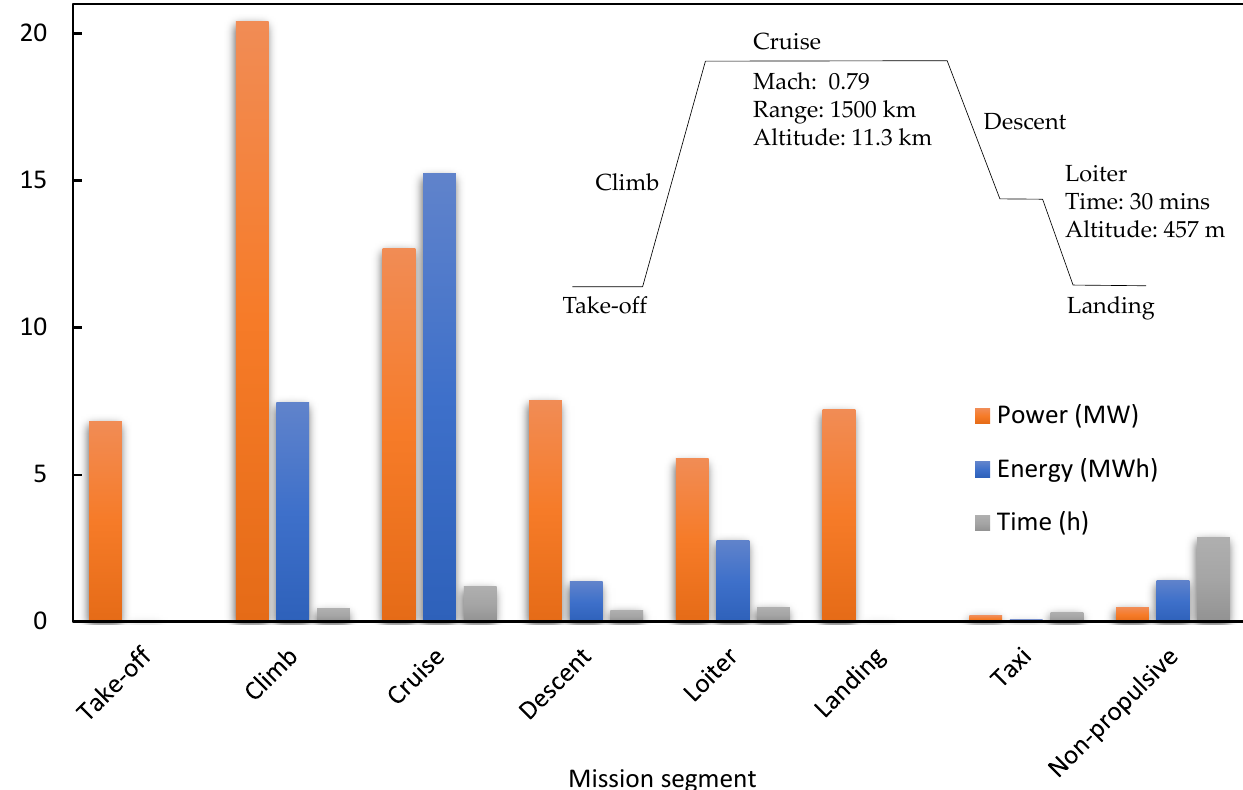
Figure 7. Power and energy consumption of the baseline A320 (total energy = 28.4 MWh).